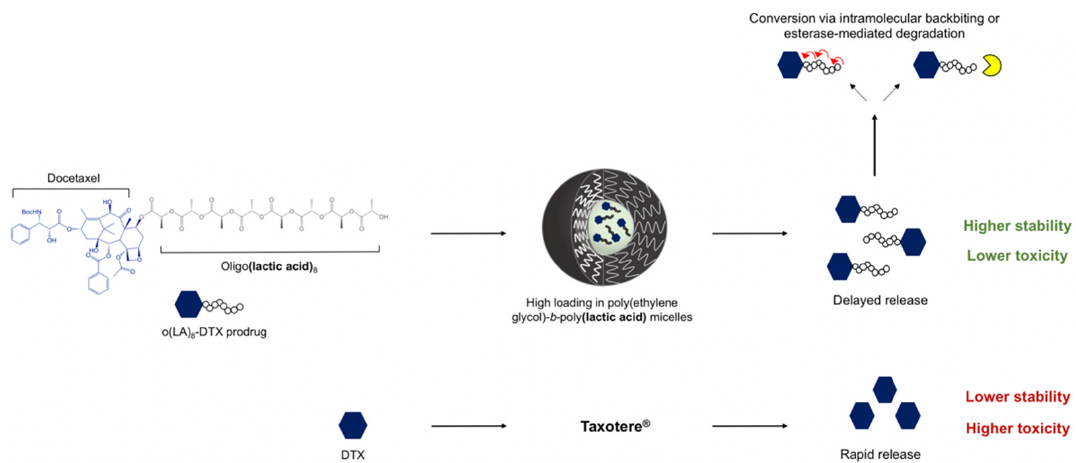
Figure 1. Improved formulation properties with o(LA) 8 -DTX vs. Taxotere ® . Conjugation of the o(LA) 8 promoiety leads to enhanced compatibility with the hydrophobic core of PEG- b -PLA micelles and greater payload stability. Following release, o(LA) 8 -DTX prodrug is converted to DTX through intramolecular backbiting or cleavage via plasma esterases.